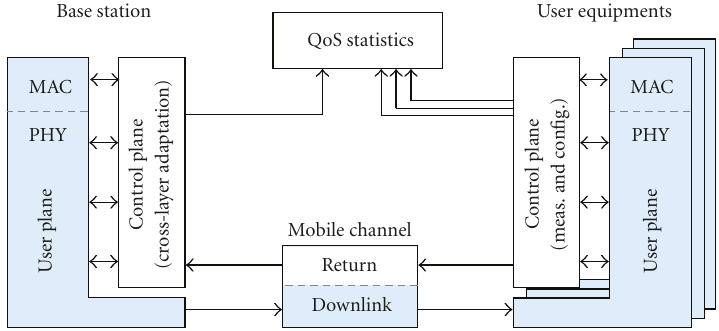
Figure 1: Simplified Simulator